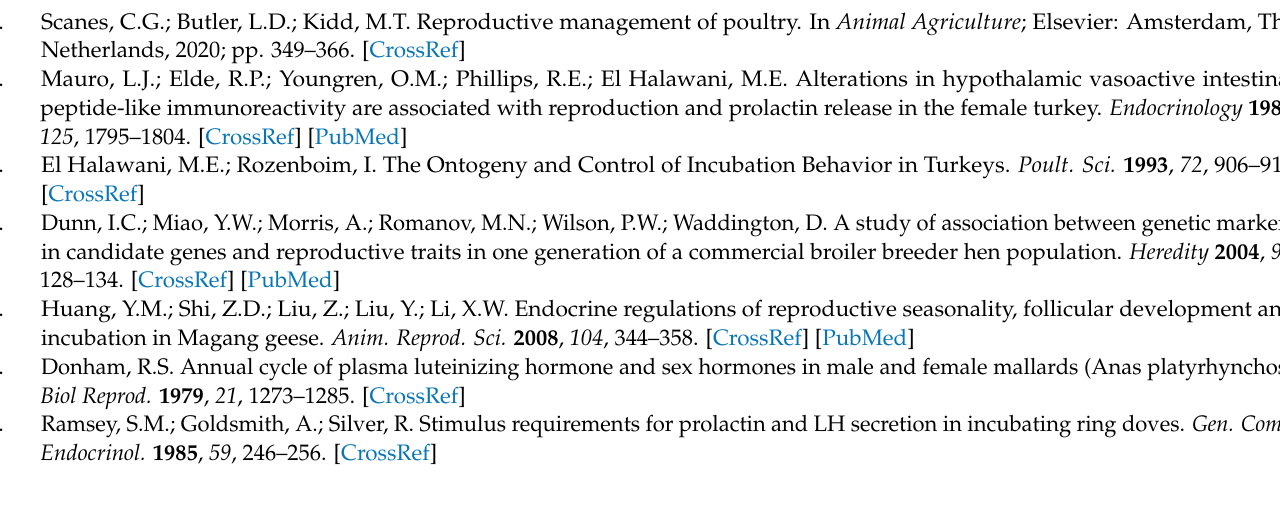
the TSS and TES; Figure S5: The Proportion of genomic locations of peaks in the two stages; Figure S6: Verification of RNA-seq data by qRT-PCR; Figure S7: Comparison of open chromatin landscape and gene expression near GPX3 in laying and broodiness stages; Figure S8: Comparison of open chromatin landscape and gene expression near LOC106036132 in laying and broodiness stages; Figure S9: Comparison of open chromatin landscape and gene expression near OTOGL in laying and broodiness stages; Figure S10: Comparison of open chromatin landscape and gene expression near PCDH18 in laying and broodiness stages; Figure S11: Comparison of open chromatin landscape and gene expression near PRL in laying and broodiness stages. Table S1: Summary of ATAC-seq data in pituitary between Laying and brooding stage; Table S2: Binding motifs of transcription factors identified in pituitary of laying stage by HOMER; Table S3: Binding motifs of transcription factors identified in pituitary of brooding stage by HOMER; Table S4:Summary of RNA-seq data in pituitary between Laying and brooding stage; Table S5:Differentially expressed genes in pituitary between laying and brooding stage; TableS6: annotation for DARs between laying stage and brooding stage; Table S7: Transcription factors predicted in DARs-DEGs; Table S8:Transcription factors enriched in DARs-DEGs in laying stage; Table S9:Transcription factors enriched in DARs-DEGs in brooding